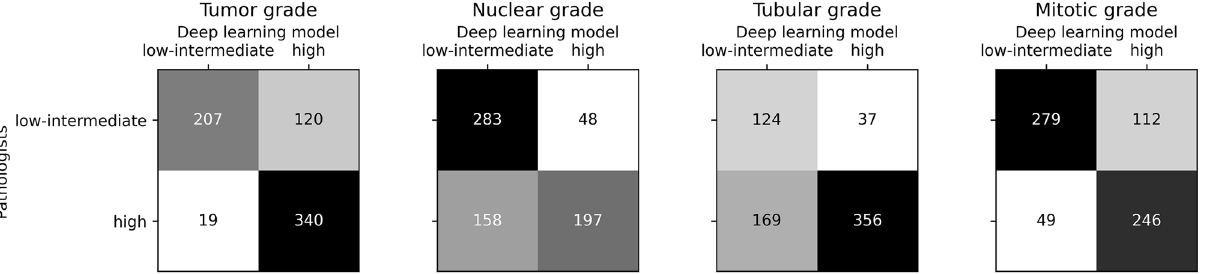
Figure 2. Confusion matrices for no special type (NST) tumor grading and grade components (nuclear, tubular and mitoses scores) between pathologists and the deep learning model. These results are on the test set (n =